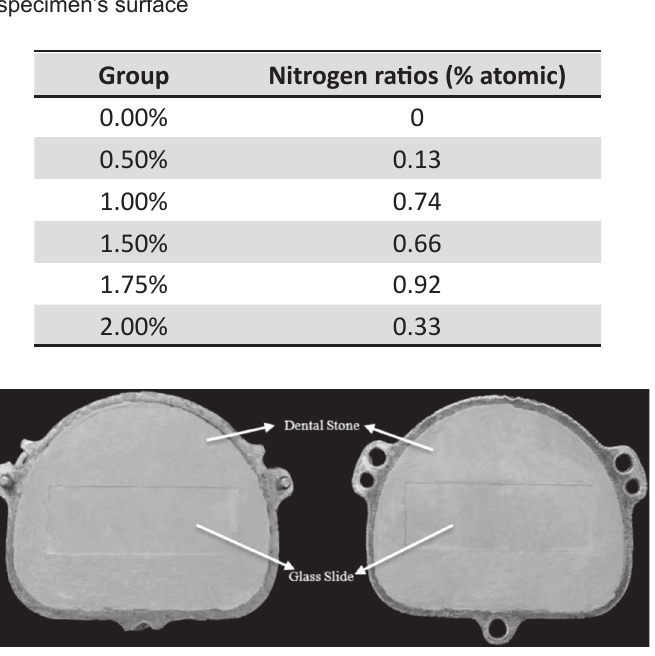
Figure 1- Glass slides invested in metal flasks supported by dental